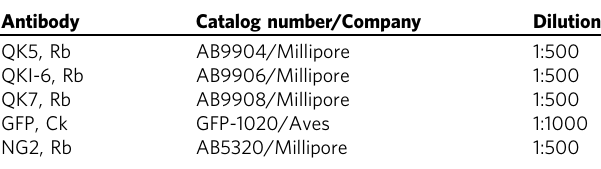
Table 1 Antibodies and dilutions used for immuno fl